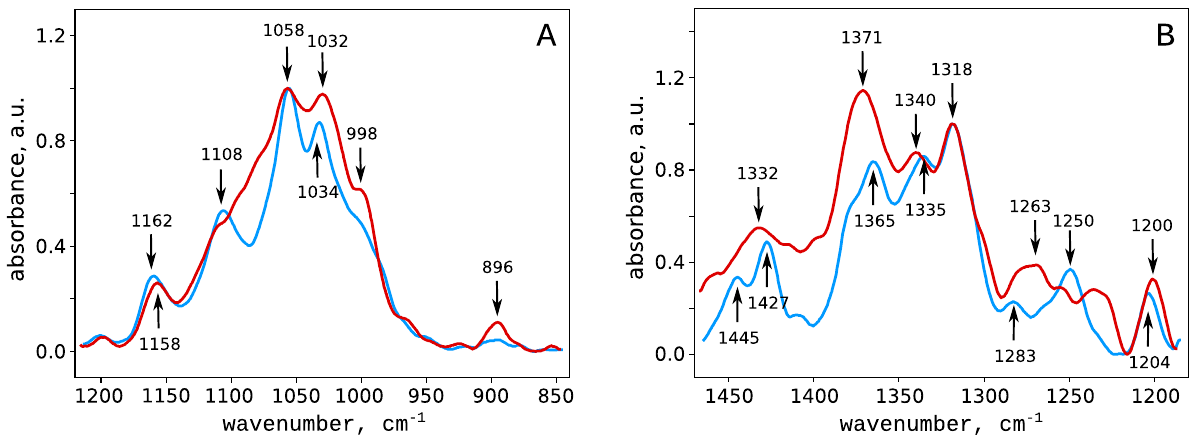
Figure 4. Infrared absorption spectra of the initial (blue curves) and mercerized (red curves) hardwood cellulose. For clarity, the spectra were spitted into two ranges: 1200–850 ( A ) and 1450–1200 cm −